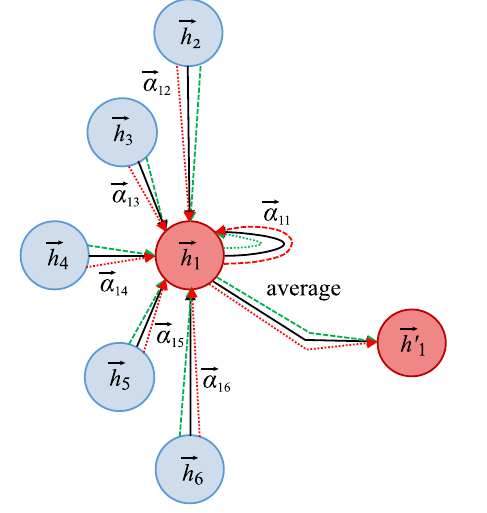
Fig. 4 An example of computing multi-head attention (with K = 3 heads) for central node ( h 1 ) and its neighbor nodes ( h 2 – h 6 )